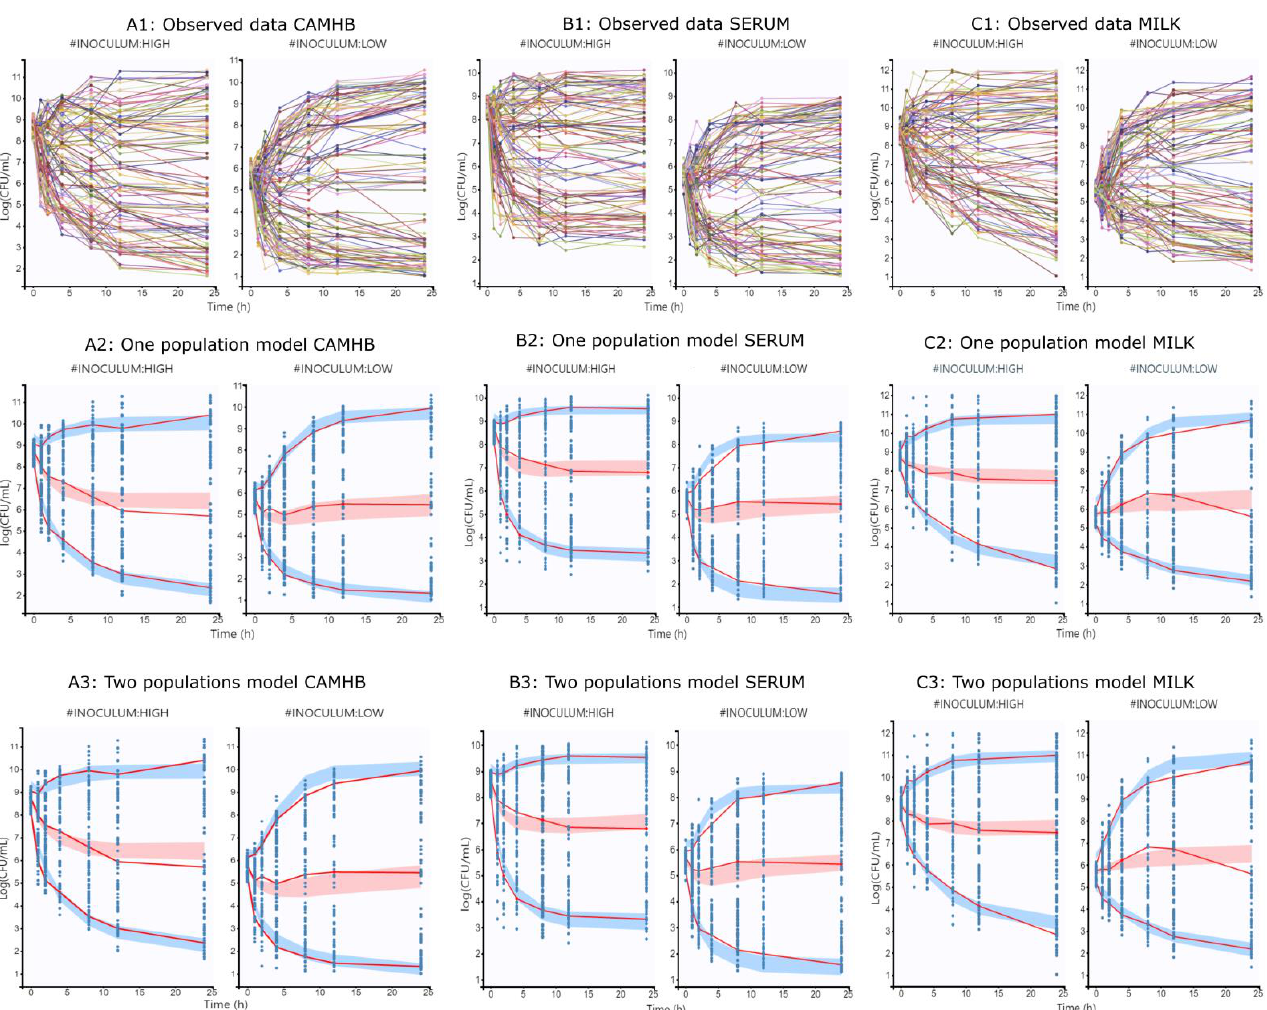
Figure 2. Plots of observed time kill curves stratified by inoculum size. ( A1 ): Data from CAHMB; ( A2 ): Visual predictive checks plots after modeling CAMHB data with one population model; ( A3 ): Visual predictive checks plots after modeling CAMHB data with two populations model; ( B1 ): Data from serum; ( B2 ): Visual predictive checks plots after modeling serum data with one population model; ( B3 ): Visual predictive checks plots after modeling serum data with two population model; ( C1 ): Data from milk; ( C2 ): Visual predictive checks plots after modeling milk data with one population model; ( C3 ): Visual predictive checks plots after modeling milk data with two population model.